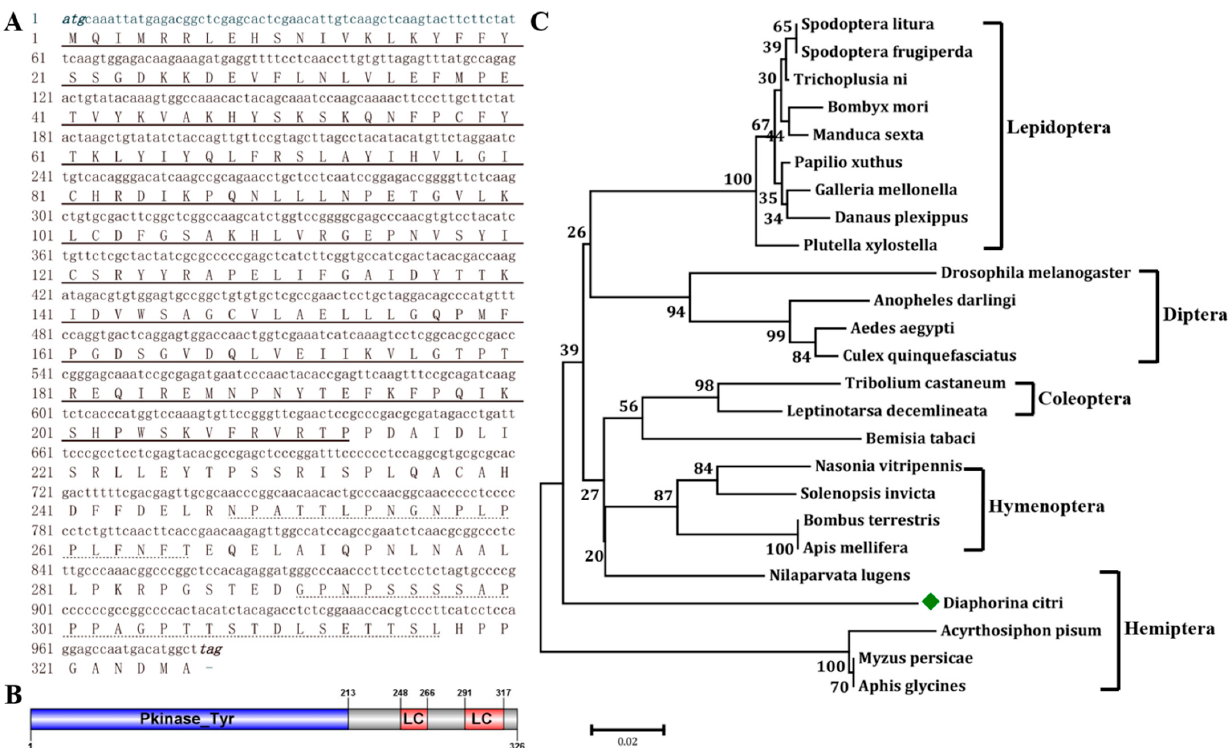
Figure 1. Bioinformatics analysis of DcGSK3. ( A ) The nucleotide and amino acid sequence of DcGSK3 gene. Numbers on the left side represent nucleotide and amino acid positions. The black solid line indicates Pkinase_Tyr domain. The black dotted line indicates low complexity domain. ( B ) The structural domain analysis of DcGSK3 protein. The blue region indicates the Pkinase_Tyr domain and the red region indicates the low complexity (LC) domain. ( C ) Phylogenetic tree analy- sis of D. citri GSK3 with other insect species. The green rhombus indicates the DcGSK3.